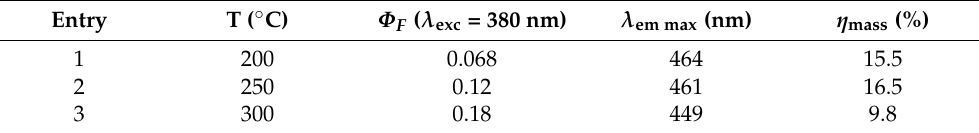
Table 2. Temperature effect on the C-dots’ luminescence and reaction yield 1 .